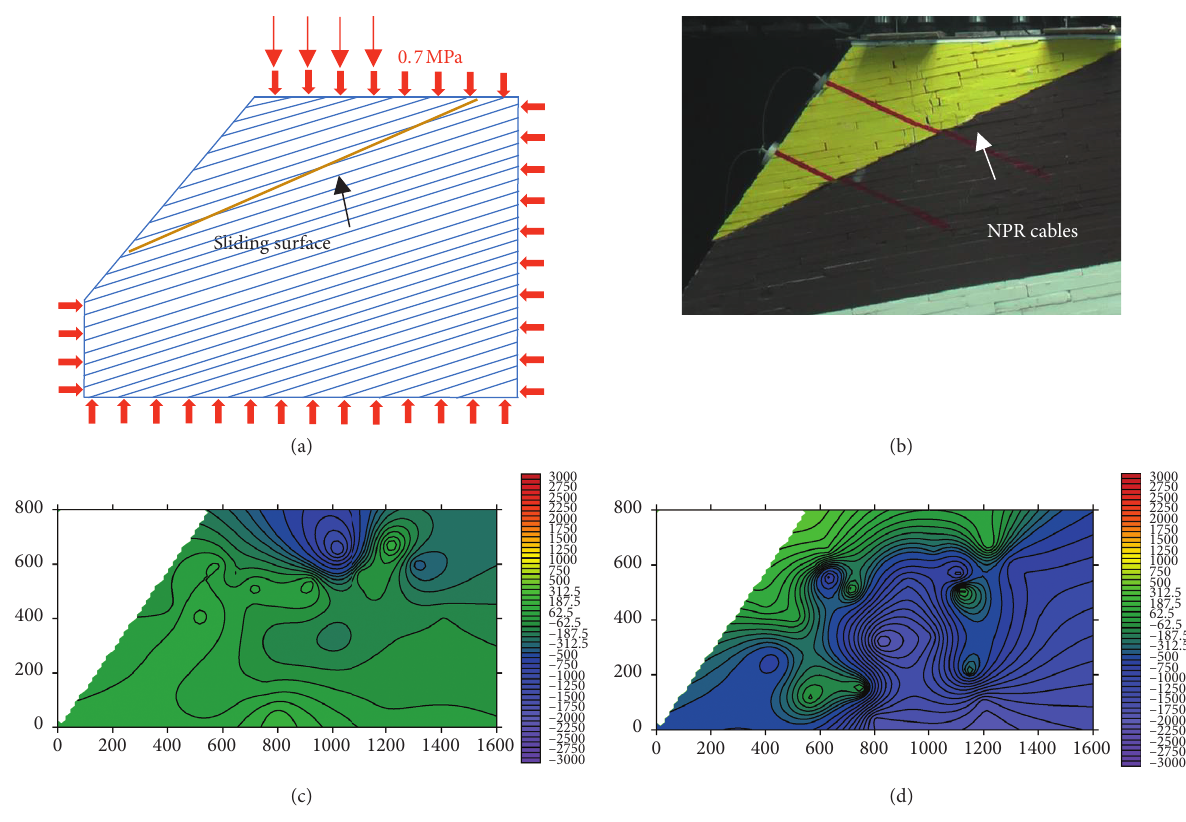
Figure 16: Third loading stage stable strain cloud map. (a) Model loading diagram. (b) Model loading variation diagram. (c) X-directional strain cloud map. (d) Y-directional strain cloud